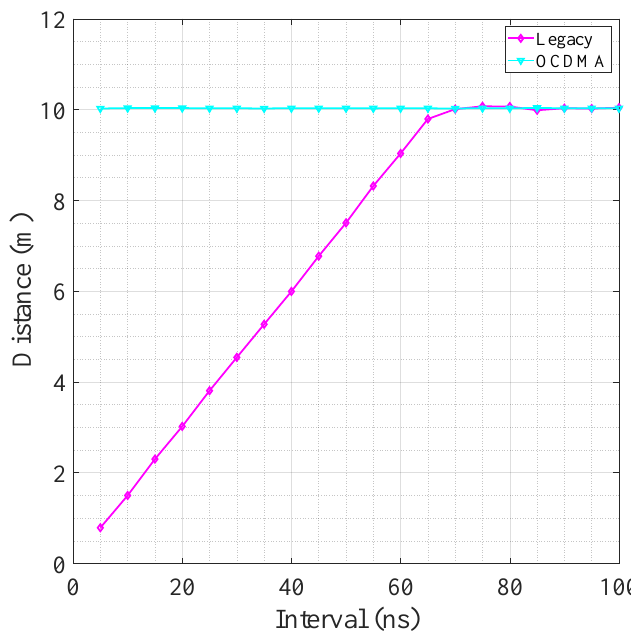
Figure 6. Measured distance for each pulse emission time interval.